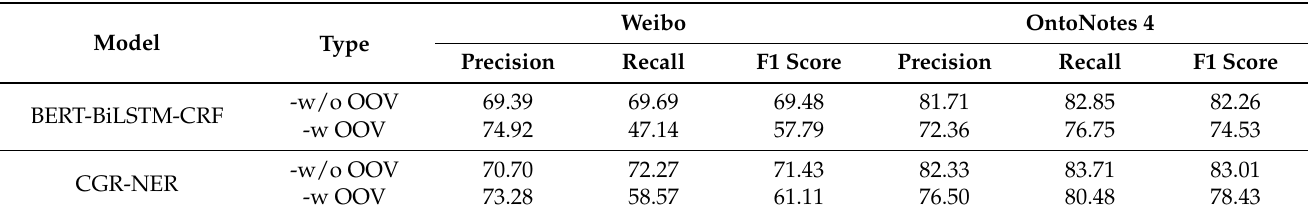
Table 11. NER model performance on the test subset with and without out-of-vocabulary characters.